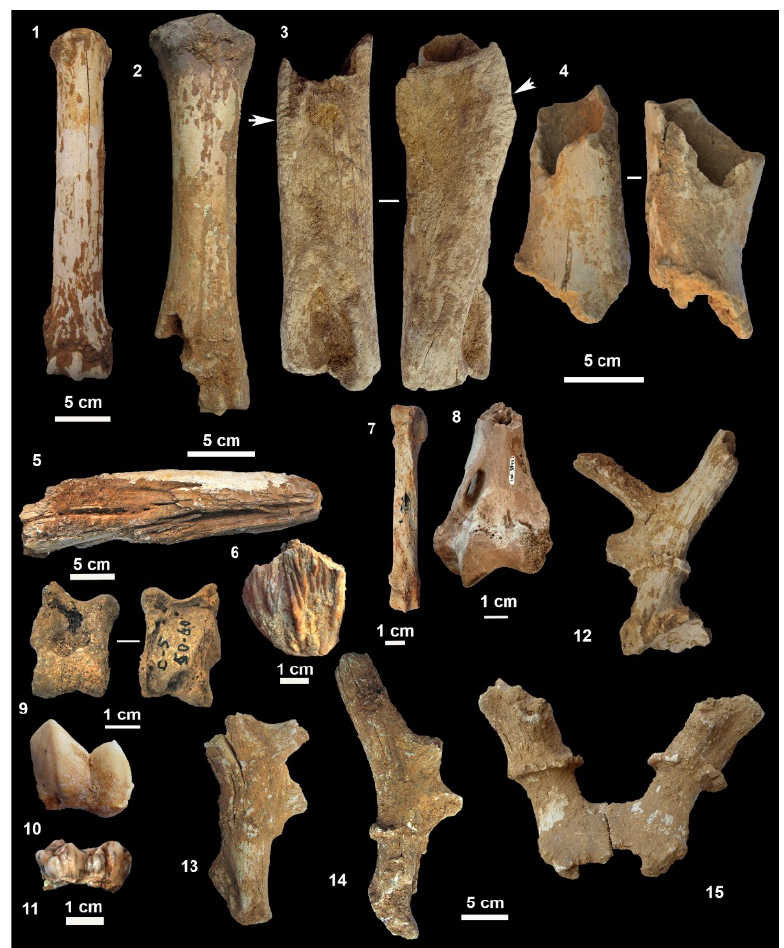
Figure 6. Faunal remains from GL1 stored at Museu de Geologia de Barcelona (MGB) and